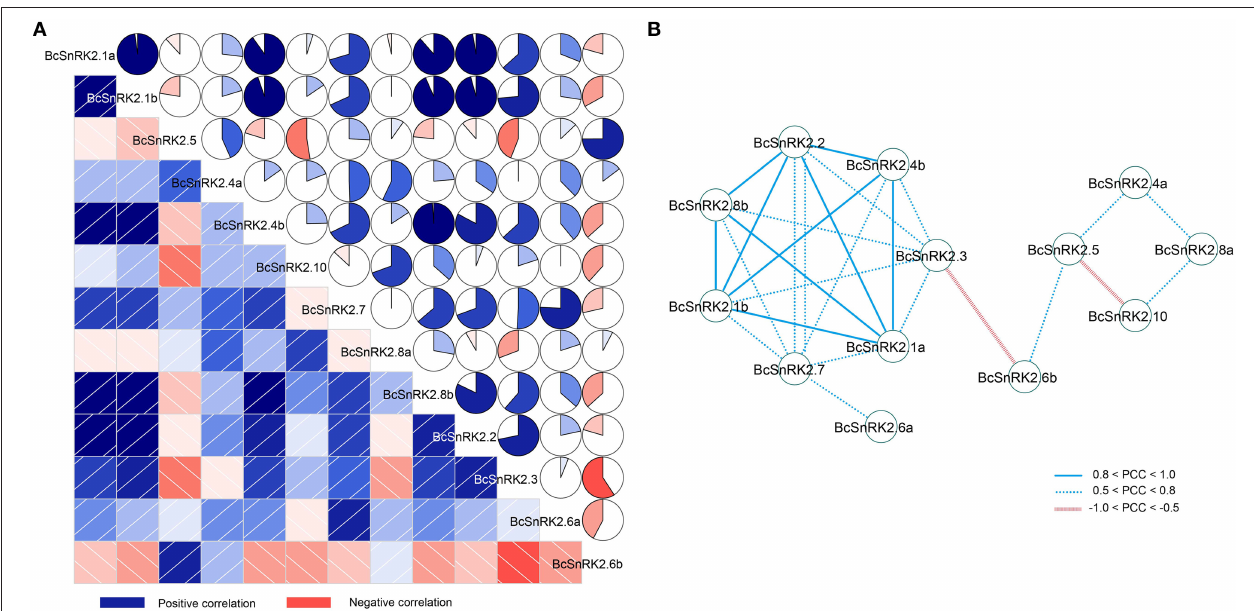
FIGURE 8 | Correlations and co-regulatory networks of 13 BcSnRK2 under cold and ABA treatments. (A) Correlation analysis by using the R package program. Lower squares: correlations indicated by color and intensity of shading; upper: circular symbols. Each correlation is shown by the shades of blue and red and the size of the fan shape. Blue and red indicate a positive correlation and negative correlation, respectively. (B) Co-regulatory networks. The co-regulatory networks of 13 BcSnRK2 under cold and ABA treatments were established based on the Pearson correlation coefficients (PCC) of these gene pairs using transformed qPCR data, which involved 13 nodes and 25 regulatory edges. The PCC of co-regulatory gene pairs was considered significant at the 0.05 significance level ( p -value), and different edge line styles indicate the different significance levels of the co-regulated gene